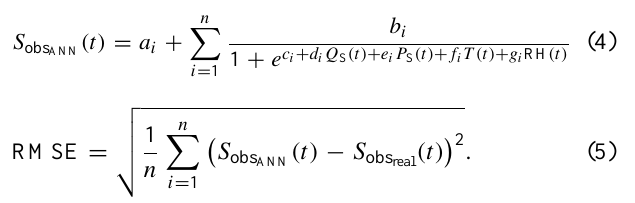
Table 7. Weights and biases ANN. 20-day time